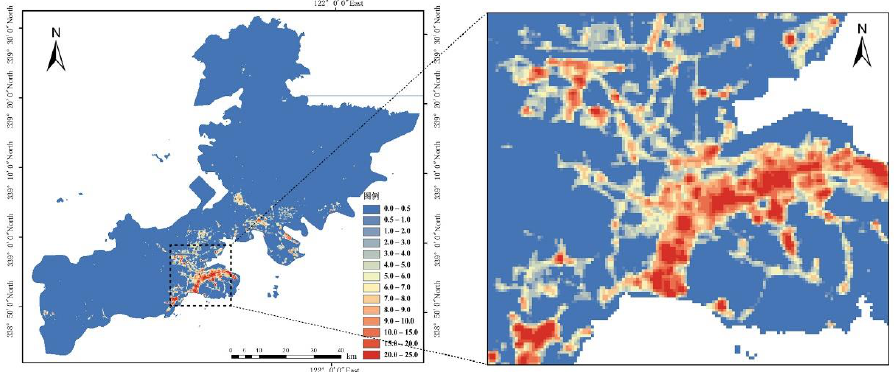
Figure 15. Inversion results of ground horizontal illuminance in main urban area of Dalian City.